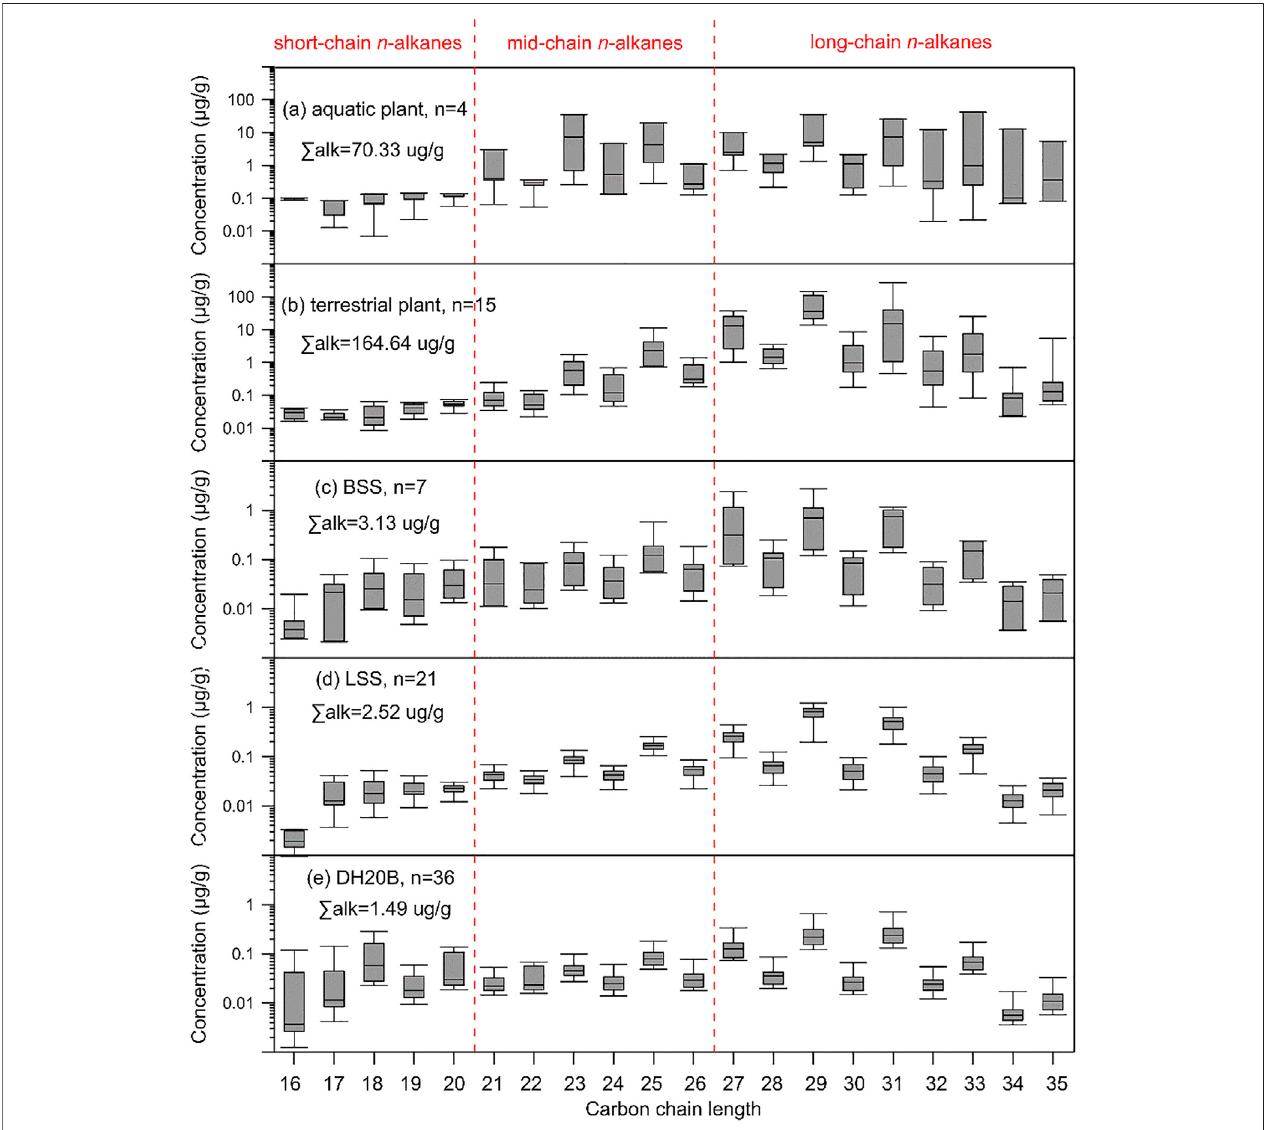
FIGURE 3 | Box-plots of n -alkane concentrations from different samples in the Daihai Lake basin. (A) Aquatic plant leaf; (B) terrestrial plant leaf; (C) BSS; (D) LSS; and (E) DH20B sediment. The y -axes are logarithmic coordinates.